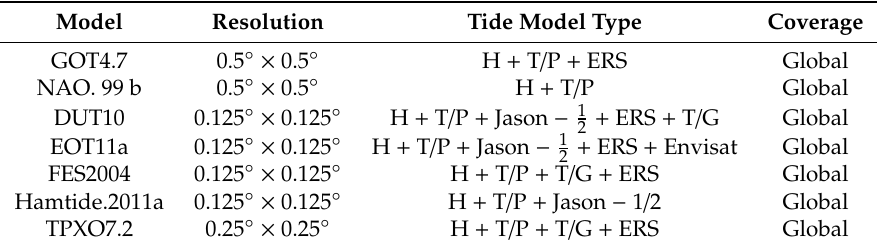
Table 2. Summary of ocean tide models